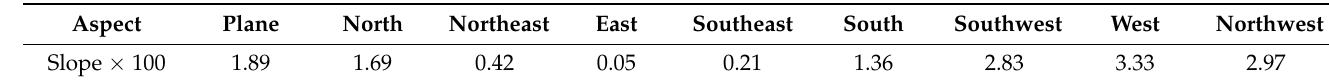
Figure 7. Trends of average temperature, accumulated precipitation and nighttime light during the growing season in the Minjiang River Basin from 2001 to 2020. Table 4. Temperature variation trend in the Minjiang River Basin based on different slope directions from 2001 to 2020.